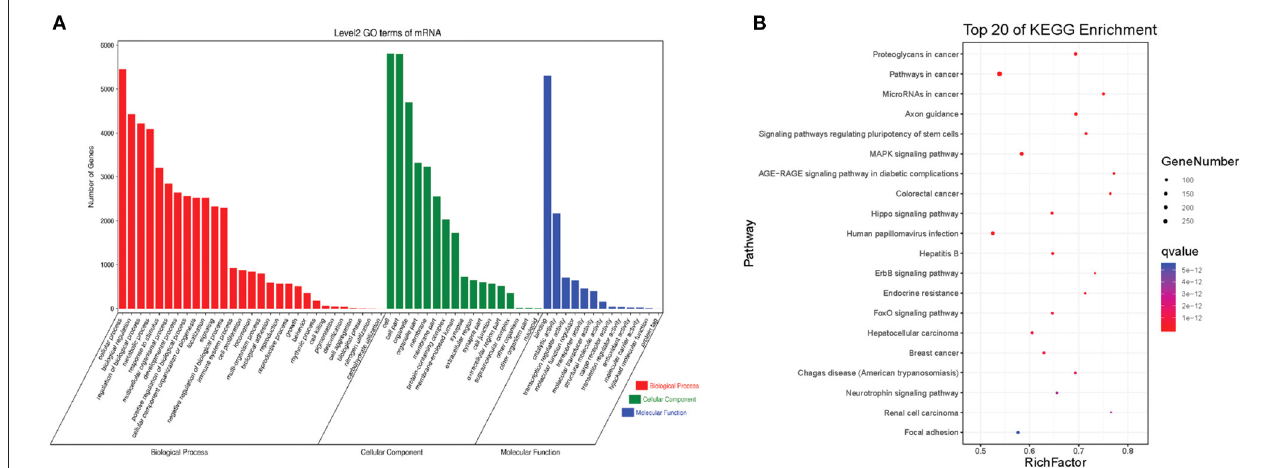
FIGURE 5 | The GO and KEGG pathway enrichment of autism-related circRNAs-miRNA-mRNA ceRNA network. (A) GO enrichment. (B) KEGG pathway enrichment. The color bar represents the q -value.